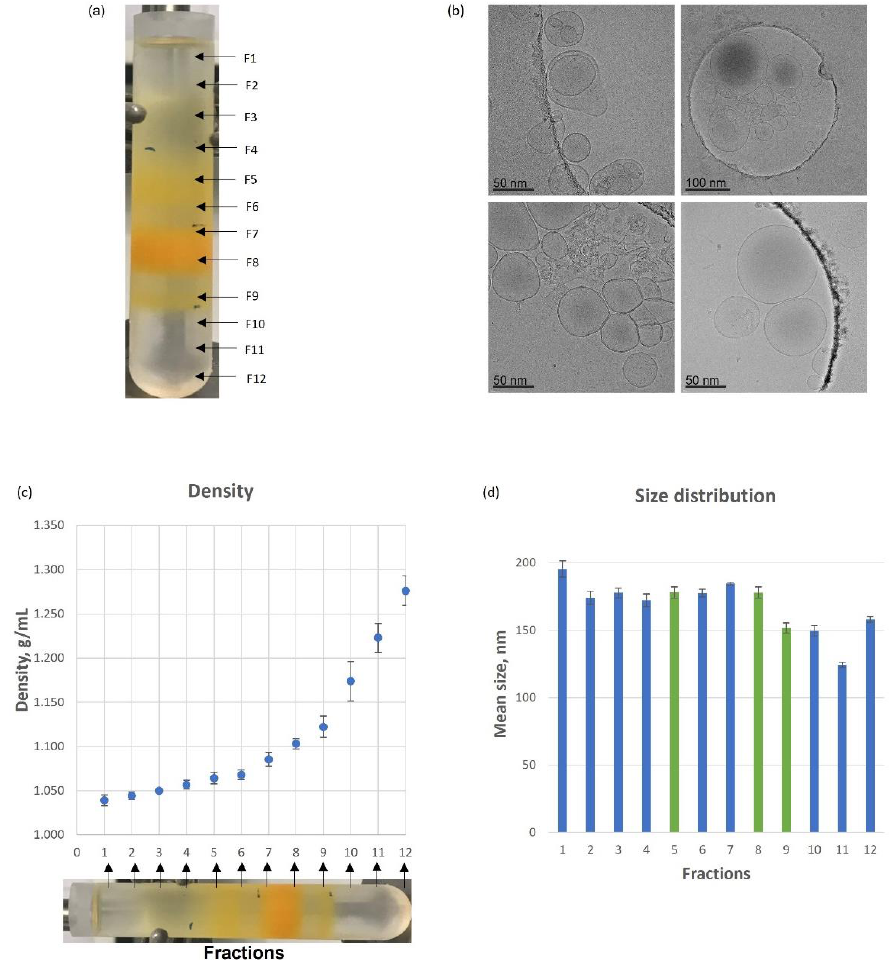
Figure 1. Separation of tomato-derived nanovesicles (NVs) into subpopulations using iodixanol density gradient ultracentrifugation (DGUC). ( a ) NVs (5 mg in protein content) were loaded and 12 fractions, F1 – F12 were collected, three colored bands at Fraction 5, 8 and 9 were observed; ( b ) representative image of cryogenic transmission electron microscopy (cryo-TEM) images of Fractions 5 and 8; ( c ) calculated densities of each fraction, n = 6); ( d ) Mean size of the particles in each fraction. The highest protein quantity was measured in Fraction 8 which corresponded to 20.8% of the total protein amount loaded (Figure 2a) while in Fraction 1, 11 and 12 we